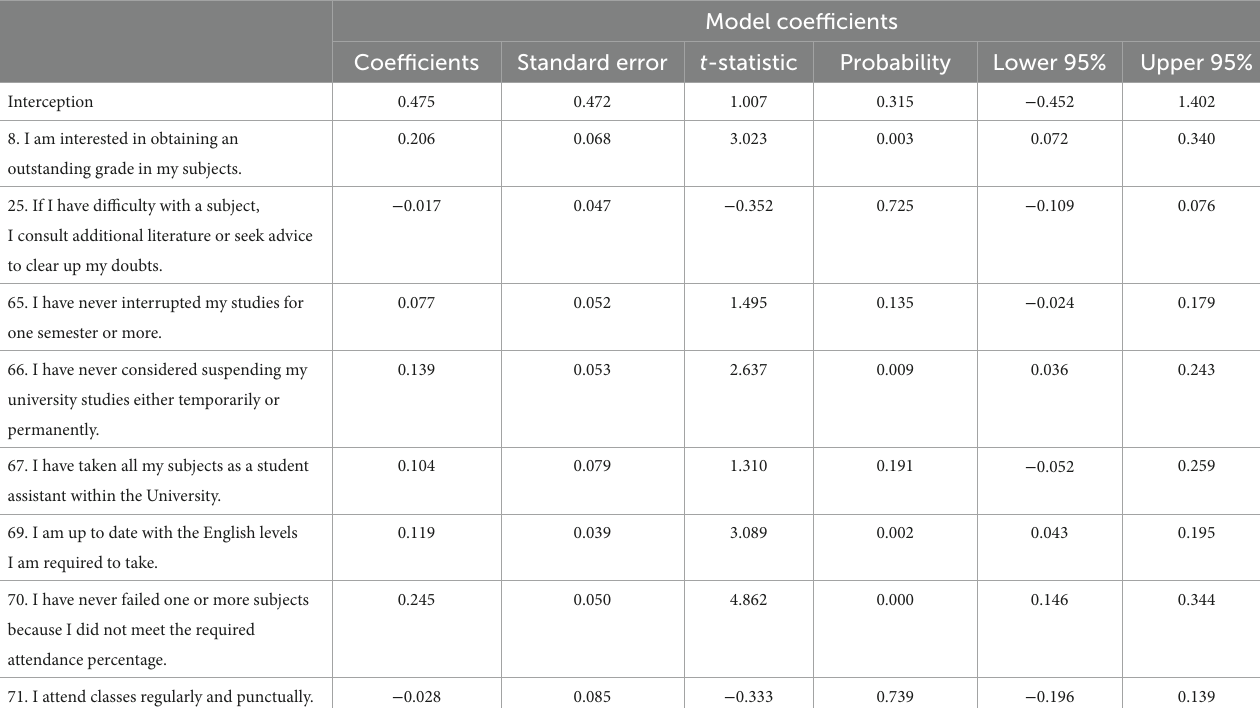
TABLE 8 Coefficient of the